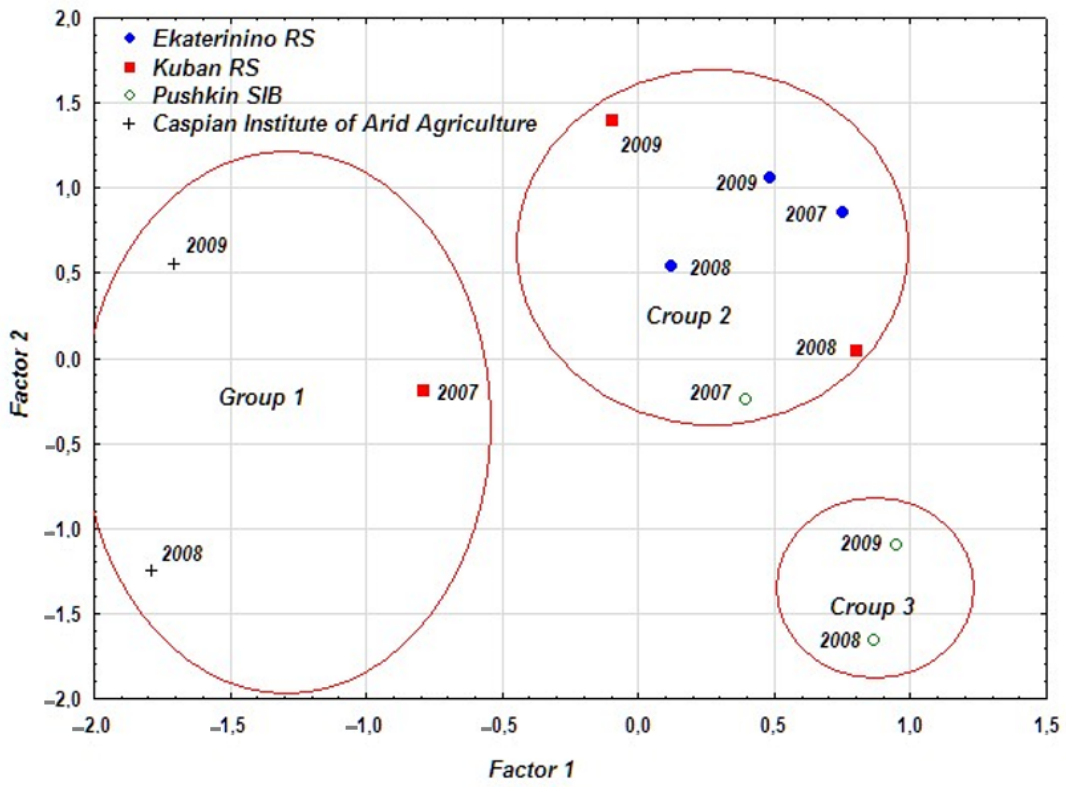
Figure 2. Distribution of environments by a set of meteorological